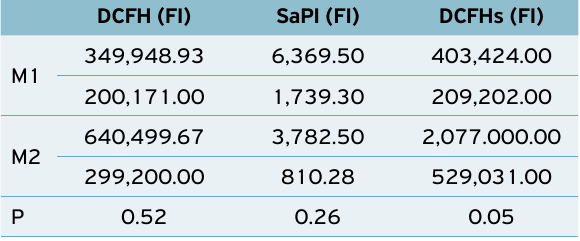
Table 2. Means (SEM) of AM fluorescence intensity (FI) of calves at basal (M1) and immunosuppressing moment (M2).